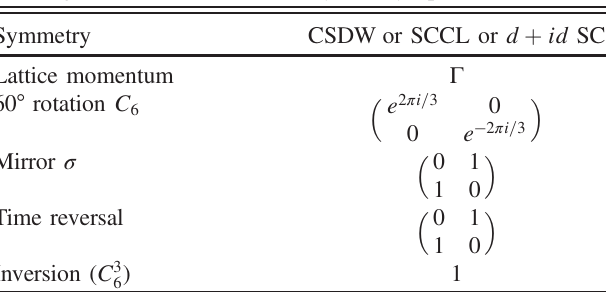
FIG. 6. Energy per site of t - J model on 8-site sample obtained by exact diagonalization. Bottom inset: Crossover between two different ground states occurs at J=t ¼ 0 . 089 ð 1 Þ . Numbers show the state degeneracy. Top inset: Lowest states with spin zero at fixed J=t ¼ 0 . 7